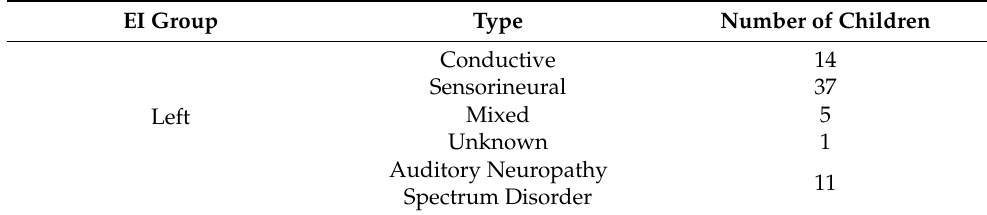
Table 3. Early Intervention (EI) group (FLI-P data points) by type of unilateral hearing